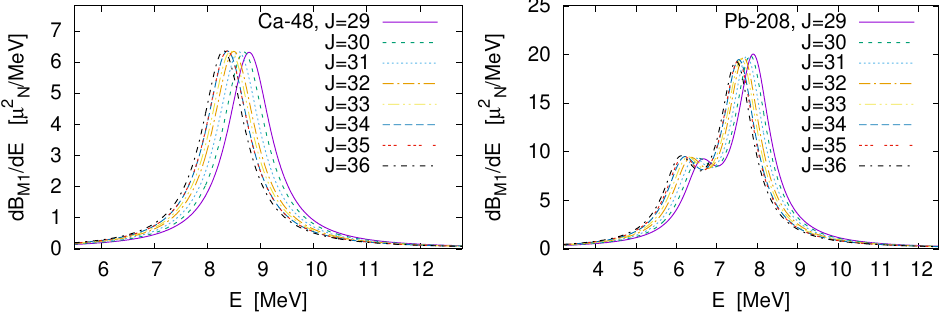
Figure 7. The M1 transition strength distribution for 48 Ca and 208 Pb obtained by the family of DD-PC interactions with the symmetry energy at the saturation, J = 29, 30, ..., 36